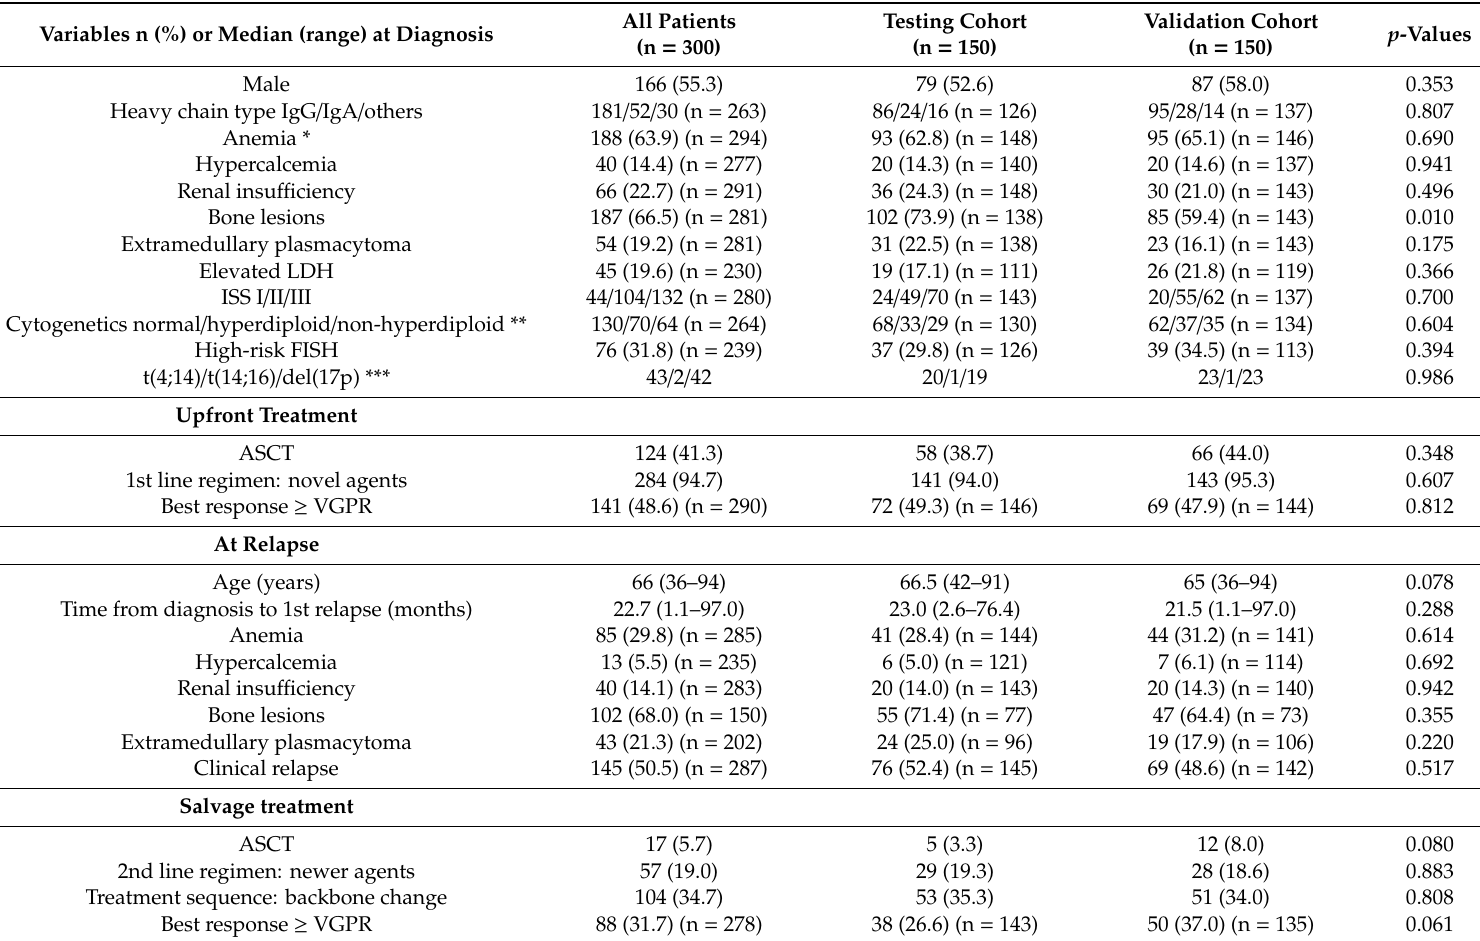
Table 1. Patients’